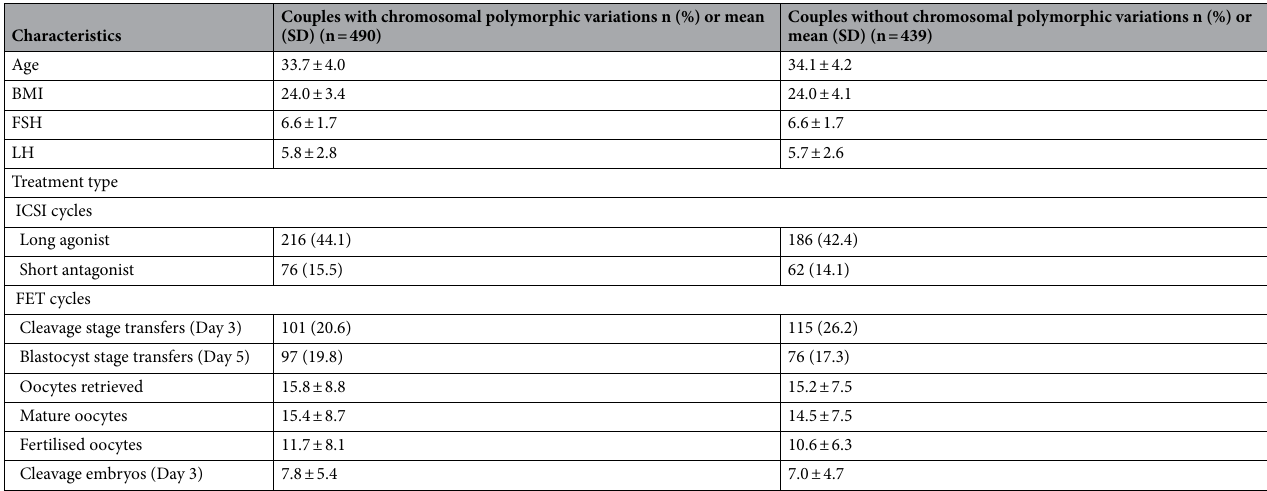
Table 1. Baseline characteristics and treatment types of the study population. BMI Body mass index, FSH Follicle stimulation hormone, LH Luteinising hormone. ICSI Intra Cytoplasmic Sperm Injection, FET Frozen Embryo Transfer.